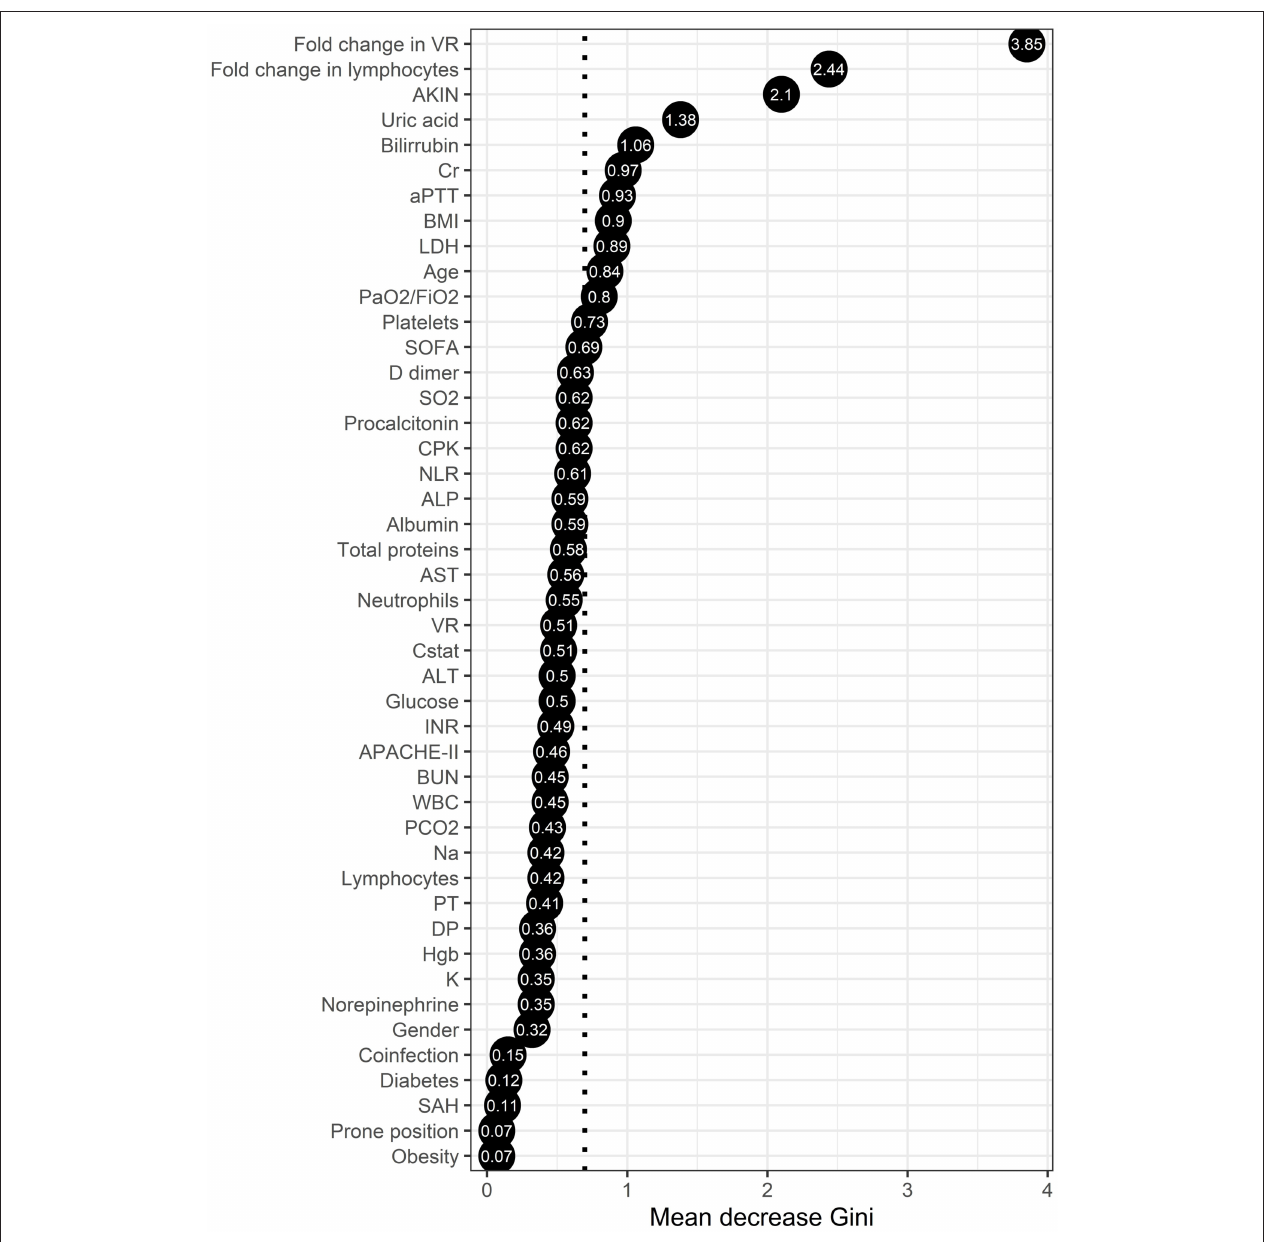
FIGURE 1 | Random forest analysis of the clinical characteristics associated with mortality in critically ill COVID-19 patients. The points represent the mean decrease Gini values, indicative of the importance of each variable to mortality. Variables with mean decease Gini values above the mean importance of the model (discontinuous vertical line) were considered as the most explicative variables of severe COVID-19-associated mortality in our